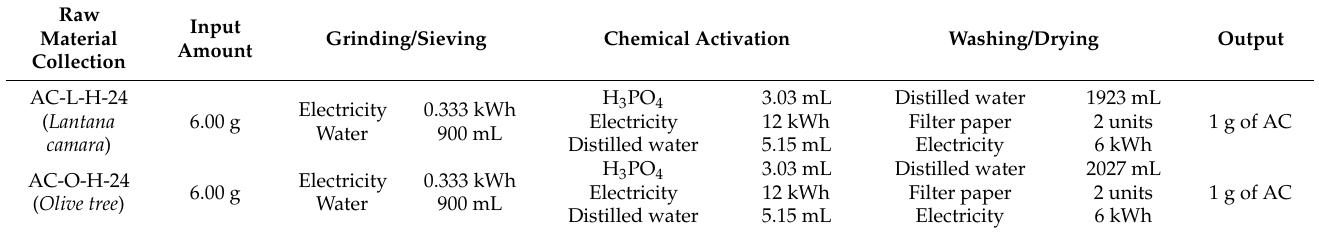
Table 3. Life cycle inventory of Lantana camara and olive tree conversion to